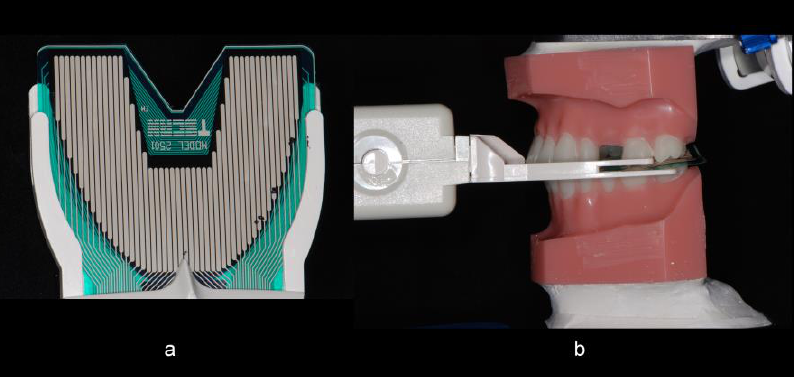
Figure 2. ( a ) The T-scan sensor was positioned on a fixed positioning jig to obtain a repeatable position for taking the occlusal reading. A weight of 1.5 lbs was placed over ( b ) the upper member of the articulator for each pair of models in groups A and B to obtain the reading.